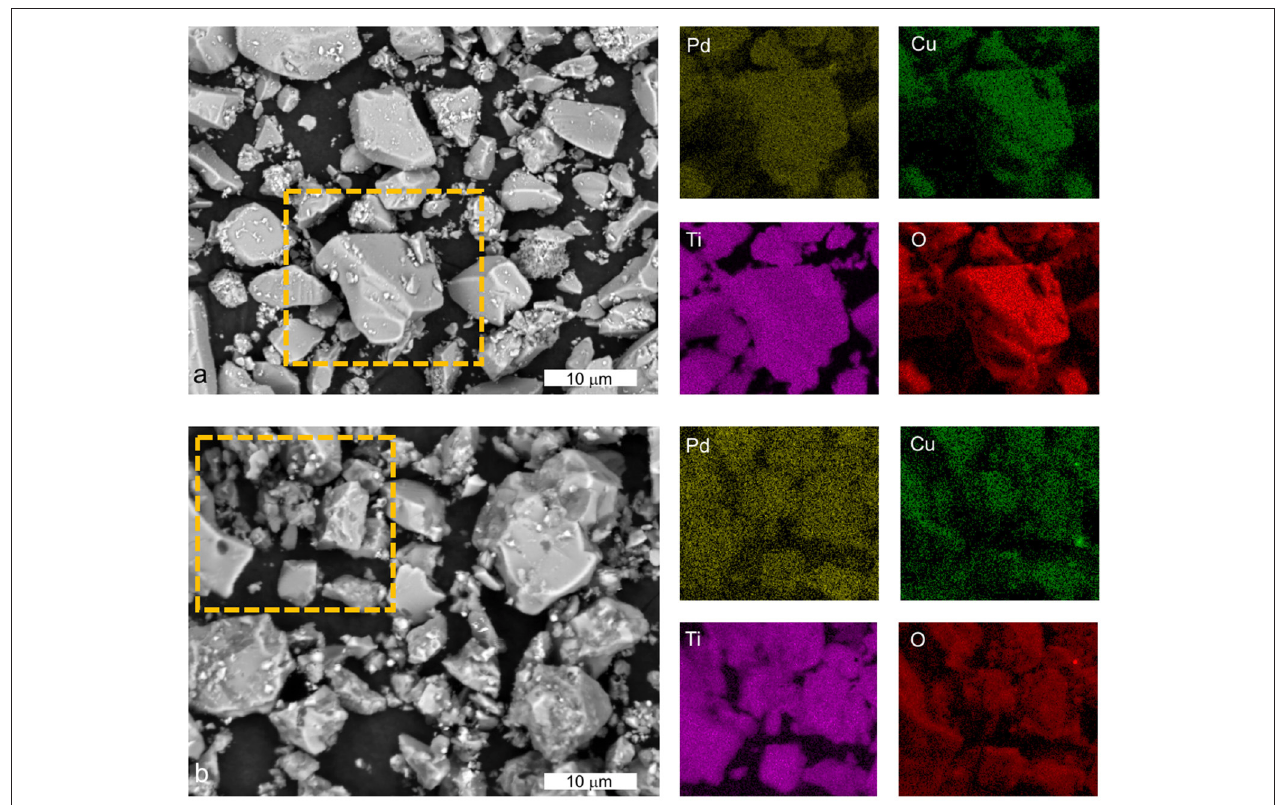
FIGURE 3 | SEM-EDX analysis of Pd-Cu/TiO 2 (a) and Pd-Cu/20CNT-TiO 2 (b) with the respective elemental mapping for Pd, Cu, Ti, and O in the selected regions (dashed rectangle).